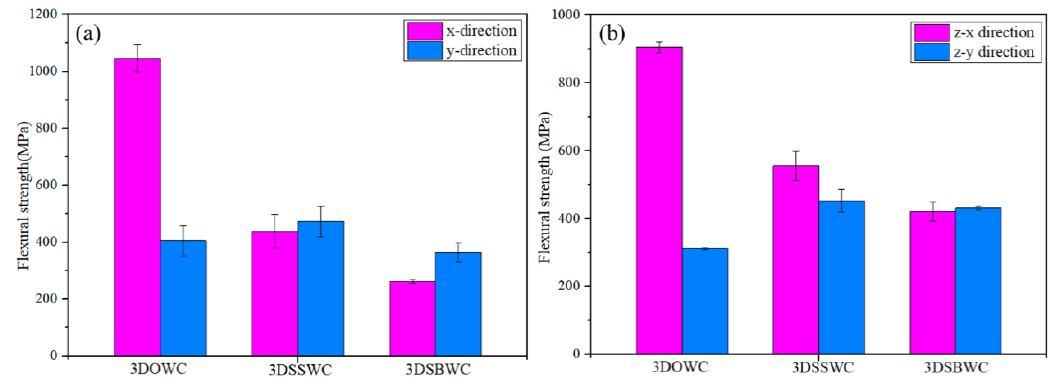
Figure 9. The flexural strength of ( a ) x- and y-direction and ( b ) z-x and z-y